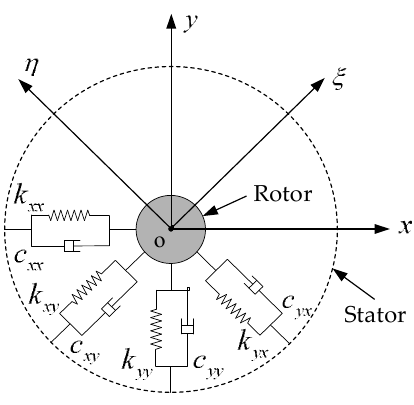
Figure 2. The diagram for the eight-coefficient model of journal bearings.